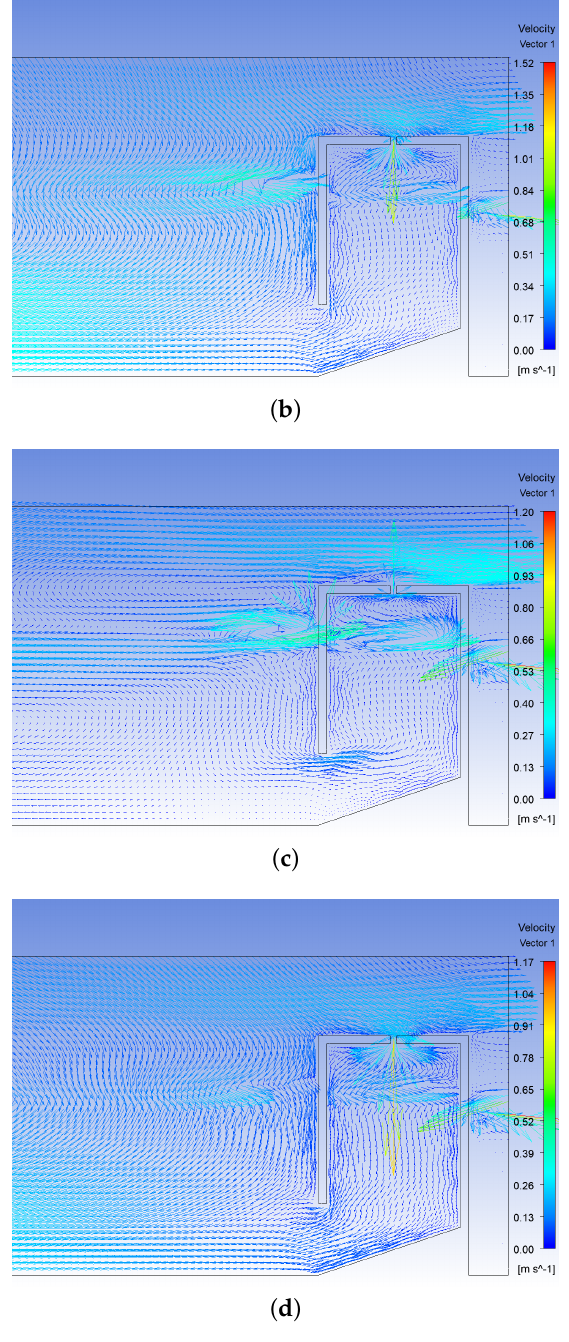
Figure 7. Velocity-vector profile at various time instants: ( a ) t = 103 s, ( b ) t = 119 s, ( c ) t = 134 s, and ( d ) t = 144 s, with H s = 1.88 m and ω p = 0.993